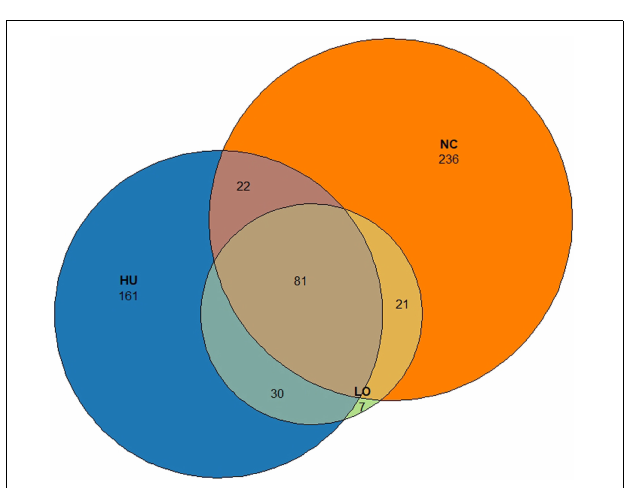
FIGURE 7 | Overlaps of membership in formal organizations HUs org ( n = 294), LOs org ( n = 139), or NCs org ( n = 360).